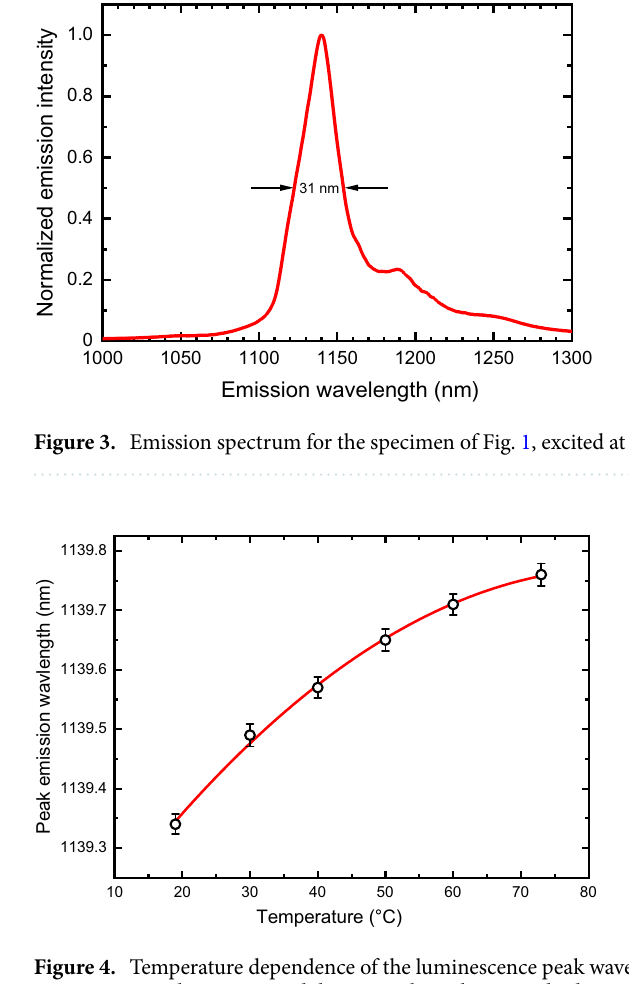
Figure 4. Temperature dependence of the luminescence peak wavelength for a sample of cured Type I/II cement. Points show measured data, error bars show standard errors of the means, and the solid curve is a quadratic fit to the